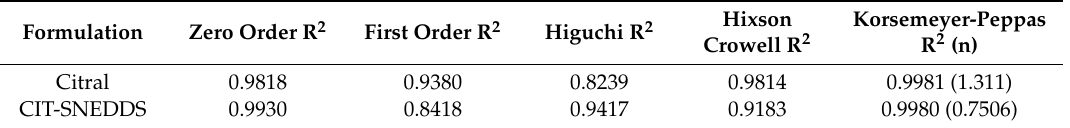
Table 5. Coe ffi cient ( R 2 ) and release exponent (n) values calculated using the non-linear regression models for in vitro release profiles of citral-loaded self nano-emulsifying drug delivery system (CIT-SNEDDS) Table 5. The summary of characterization of Citral-loaded self nano-emulsifying drug delivery system (CIT-SNEDDS).